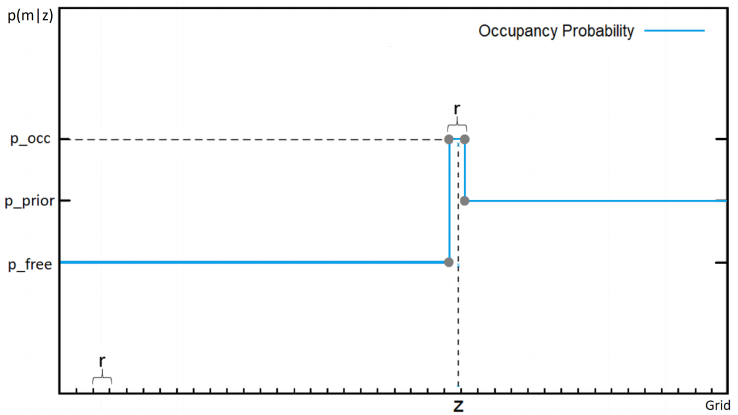
Figure 8. General two-dimensional laser inverse sensor model ( r = grid cell size, z = laser measure- ment). Reproduced from